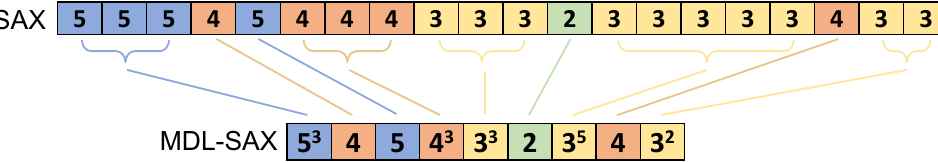
Figure 5. Illustration of MDL-SAX string created from a SAX time series representation. Consecutive equal SAX elements are collapsed to a single MDL-SAX element, with the superscript value indicating the number of